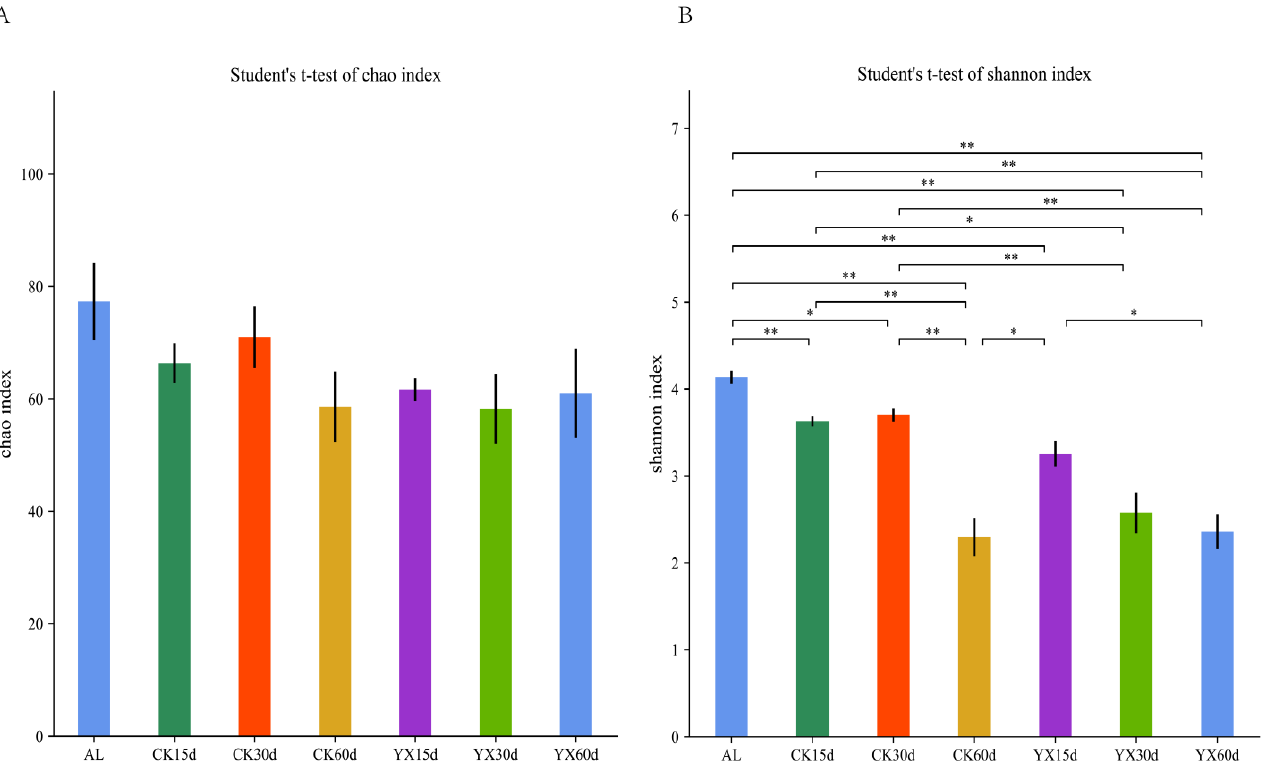
Figure 3. Bar plots of Chao indices ( A ) and Shannon indices ( B ) of bacterial communities in alfalfa silage. AL, alfalfa material before ensiling; CK, control; YX, inoculated with commercial LAB YX; the numbers following CK and YX stand for ensiled days of silage. * p < 0.05; ** p < 0.01.